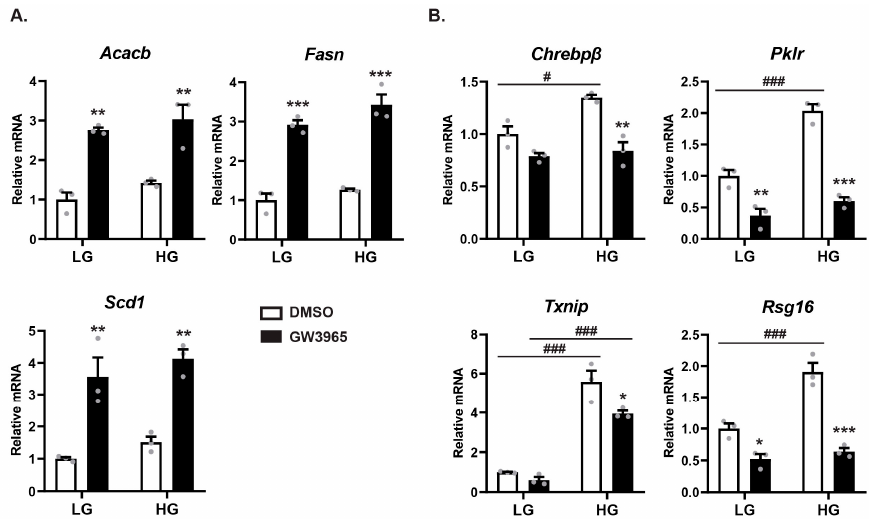
Figure 5. Ligand-activated LXR represses ChREBP α activity on ChREBP-specific target genes. Mouse primary hepatocytes were isolated and cultured in either 1 mM glucose (LG) or 25 mM glucose (HG)